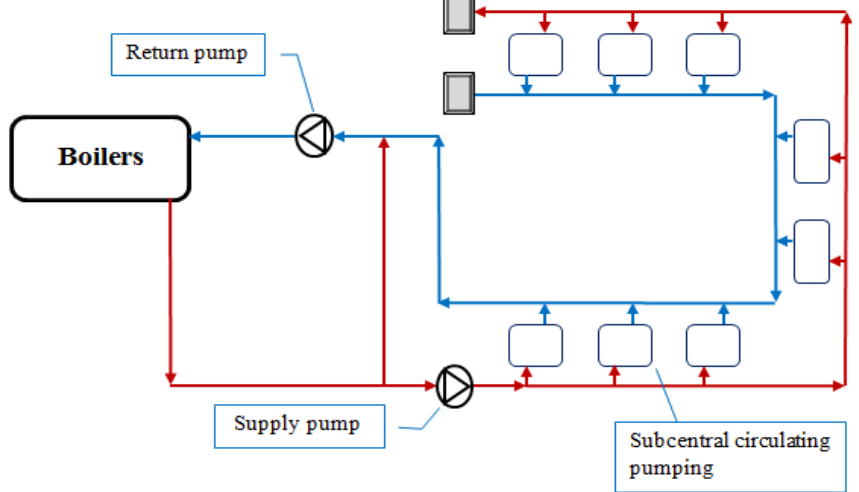
Figure 3. Primary and secondary circuits of the hospital’s hot water distribution system.